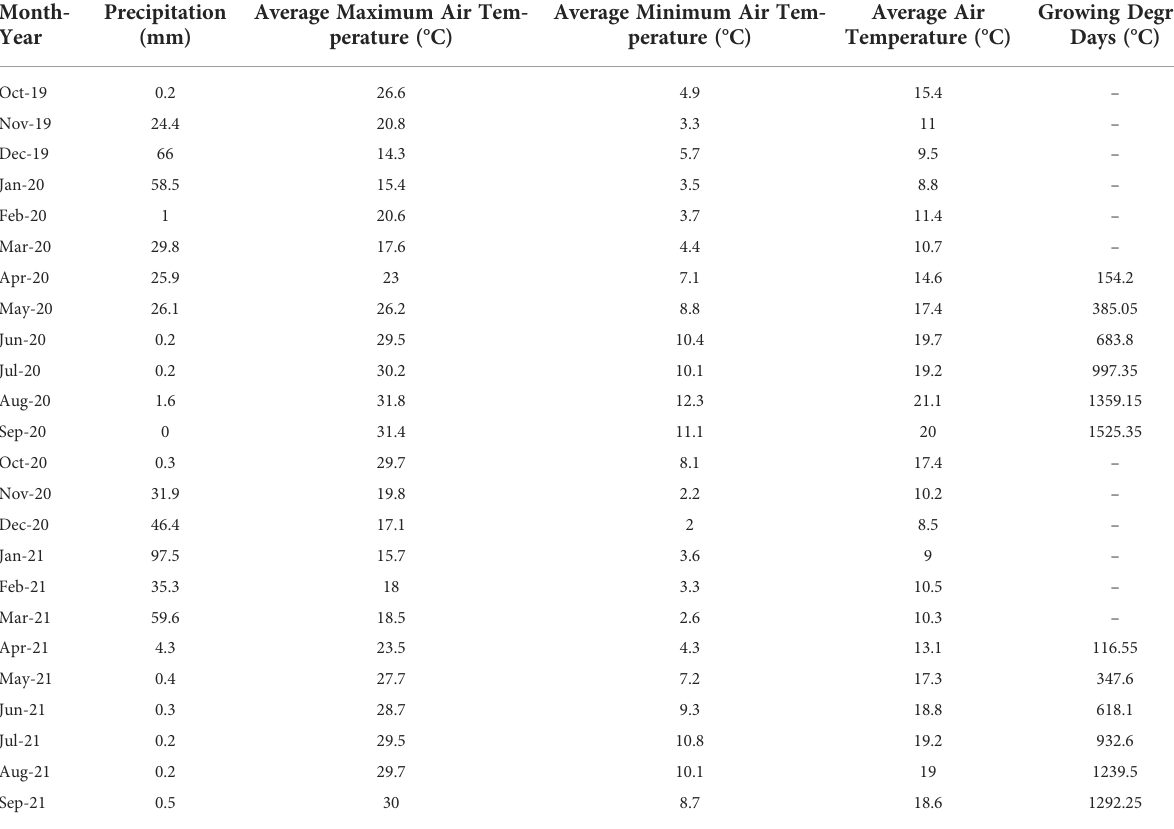
TABLE 1 Weather information at the experimental site as obtained from california irrigation management information system (cimis) station located in oakville (#77, Oakville, Napa County) a .